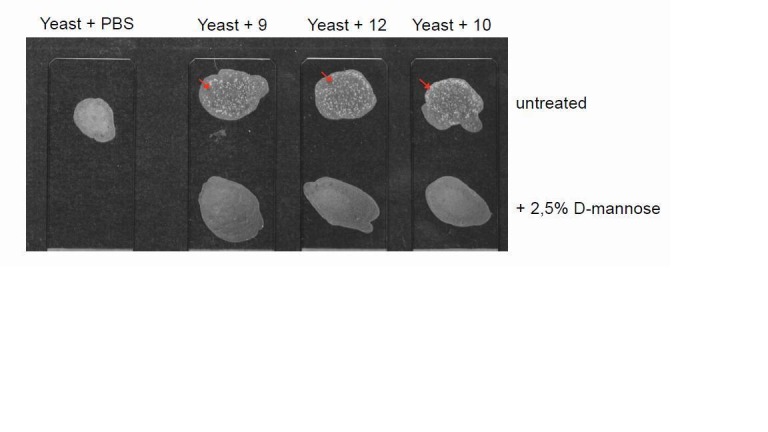
Yeast agglutination assays on uropathogentic E. coli clinical isolates.Representative images of yeast agglutination assay. The assay was performed incubating 10 µl of previously identified bacteria isolates (haemagglutination-positive isolates #9, 12, 10), grown in static condition (final concentration 2x109 cells/ml), with 10 µl of S. cerevisiae yeast strain W303 Mata (final concentration of 109 cells/ml). The appearance of white aggregates (arrows) indicates agglutination. UTI isolates were pre-incubated with D- mannose at a final concentration of 2.5% in order to identify mannose-sensitive agglutination, indicative of type 1-fimbriated phenotype. The assay was carried out in 3 replicates.